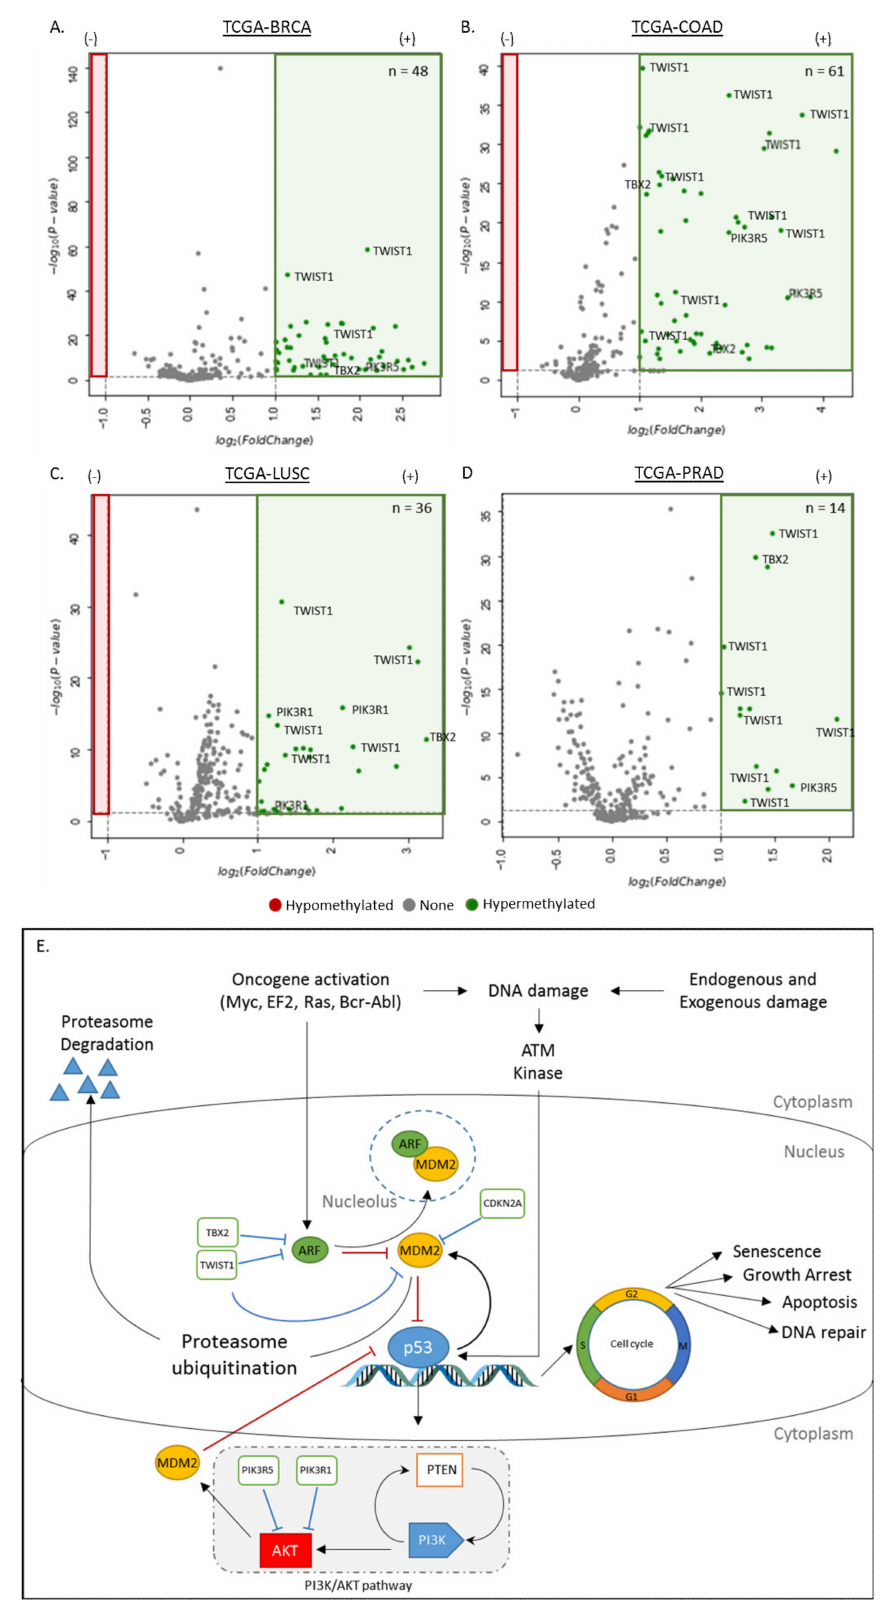
Figure 1. Hypermethylated genes in the dysregulation of the ARF-MDM2-p53 pathway in